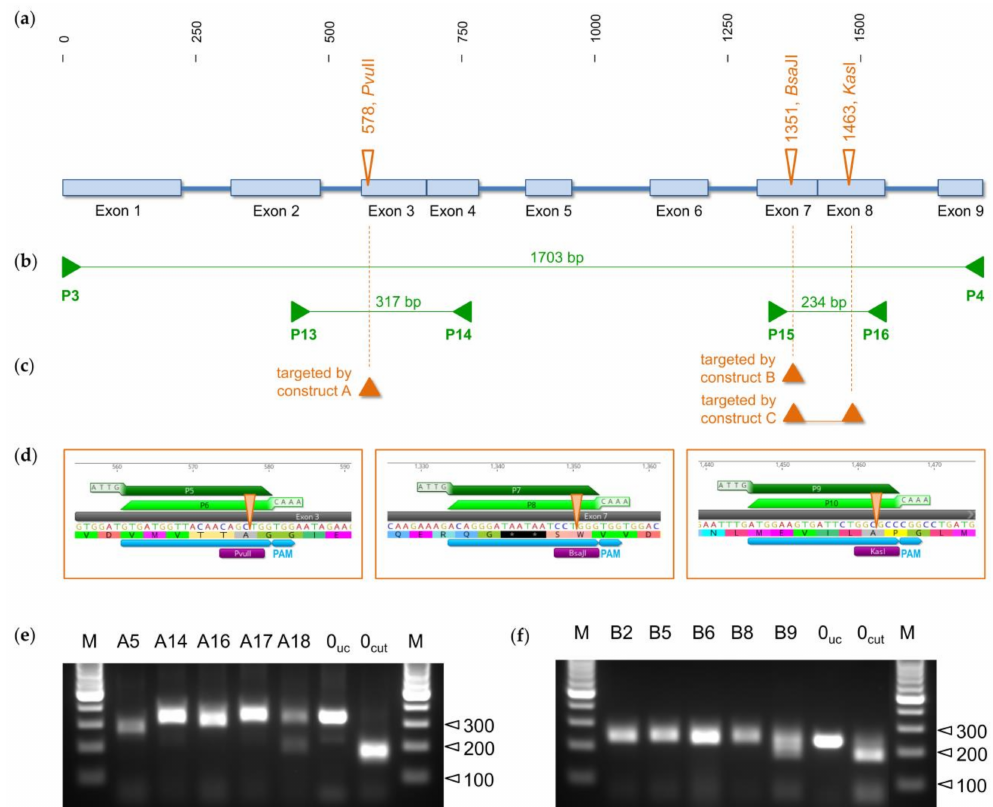
Figure 2. CRISPR/Cas9 approach for the manipulation of the hss gene. ( a ) Genomic structure of the hss gene with restriction sites at exons 3, 7, and 8 that were targeted by sgRNAs with specific protospacer motives. ( b ) Primer positions for the amplification of the complete and partial gene sections. ( c ) Gene regions targeted by the CRISPR/Cas9 constructs A, B, and C. ( d ) Protospacer sequences used in this study targeting exon 3, exon 7, and exon 8. The predicted sites of the Cas9-mediated double-strand breaks within the recognition sites of the endonucleases are indicated by arrow heads. Primers used for the sgRNA cassette are given in Table A1. PAM, protospacer adjacent motif. ( e , f ) Restriction analyses of genomic fragments amplified with primer pairs P13/P14 including exon 3 and P15/P16 covering exon 7 and 8 after incubation with Pvu II ( e ) and Bsa JI ( f ). Resulting fragments were separated on a 3% agarose gel by using the GeneRuler 100 bp DNA